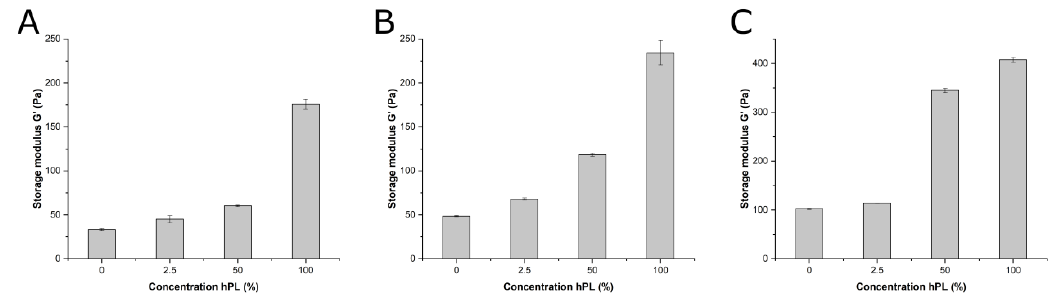
Figure 5. ( A ) Material stiffness of GelMA hydrogels (5% w/v) with a DoF of 50% (A) and a DoF of 70% ( B ) at 25 °C determined by a time-sweep oscillatory test. ( C ) Material stiffness of unmodified gelatin at 25 °C, determined by a time-sweep oscillatory test. Data represent the mean ± SD for a threefold determination.